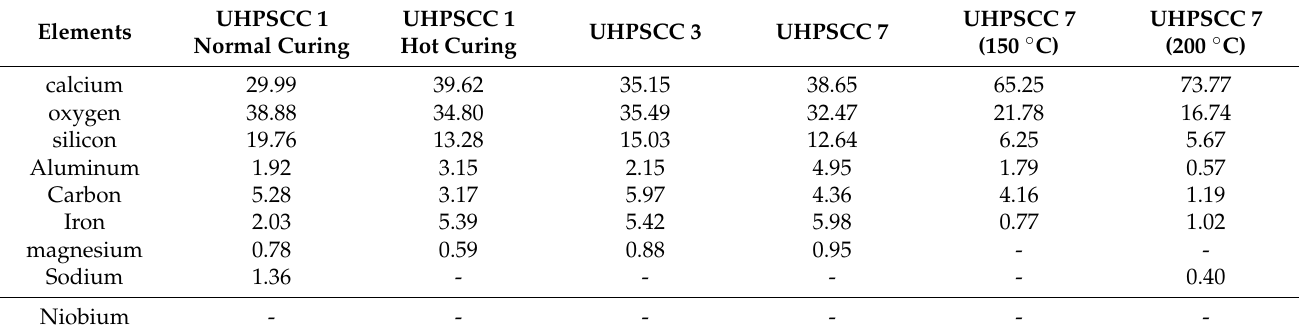
Table 5. EDX results in different UHPSCC